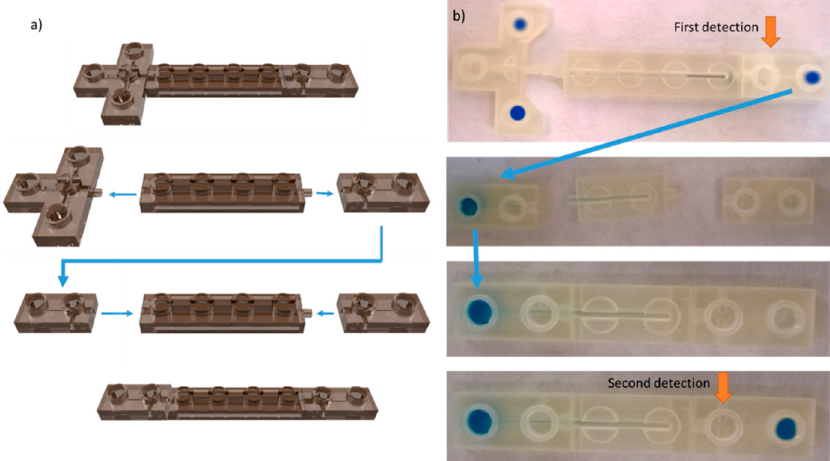
Figure 2. Computer visualization ( a ) and view of the reconfigurable modular microfluidic chip for gel electrophoresis ( b ) during electrophoretic separation and relocation of the sample between two configurations of the chips. First configuration contains T-type injector, 30 mm—long separation channel and final module. After separation in the first configuration the final module (with immobilised analyte confirmed by fluorescence detection) is detached and relocated as a first module in the second configuration. Finally, the separation is continued in the second configuration with fluorescence detection at points as marked.